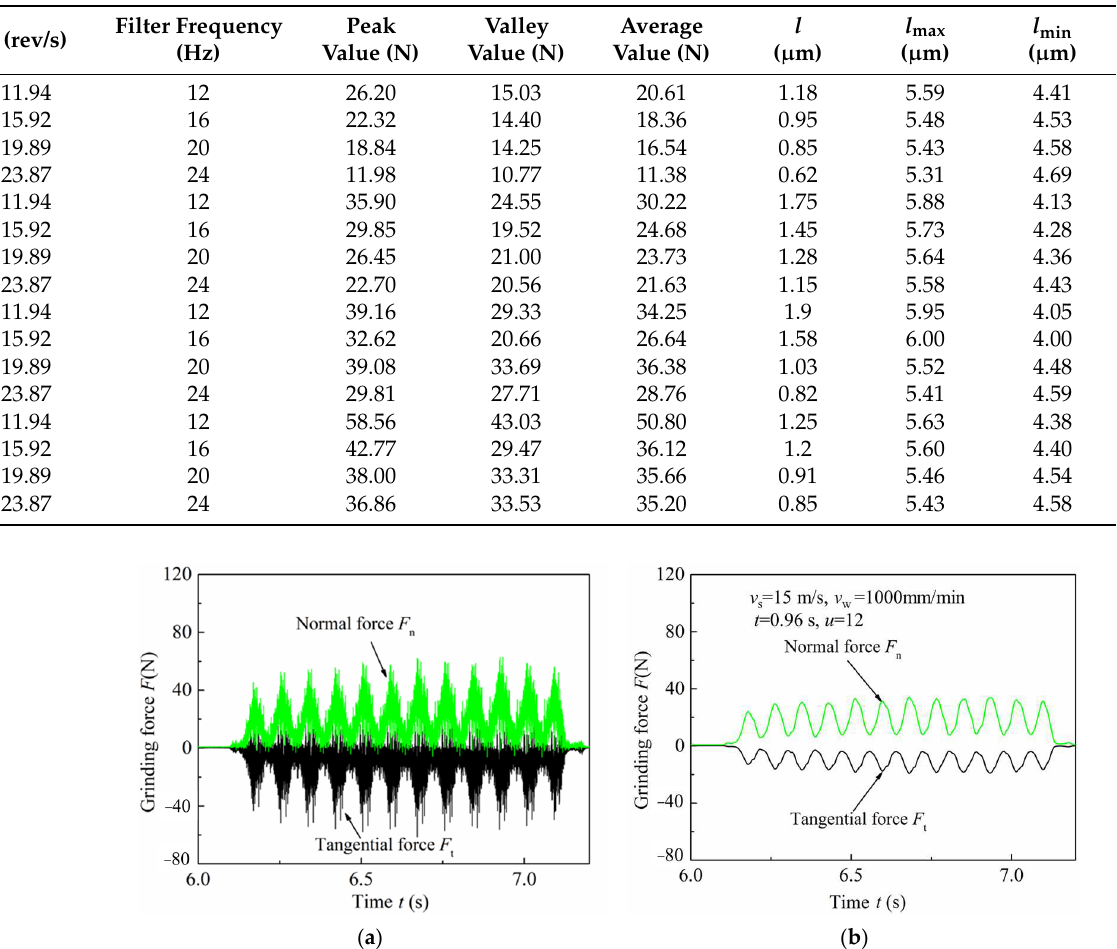
Figure 7. Curves of grinding force signal: ( a ) unfiltered; ( b ) filtered by 12 Hz.